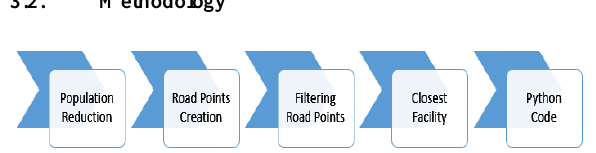
Figure 1. Flow chart of the process in finding points in UP Diliman that would give the least difference in customer